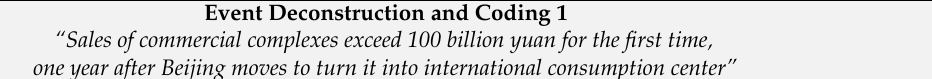
Table A1. The deconstruction and coding table of narrative